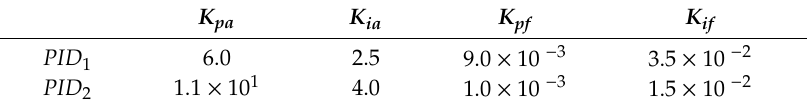
Table 3. Proportional–integral–derivative (PID) controller parameters.